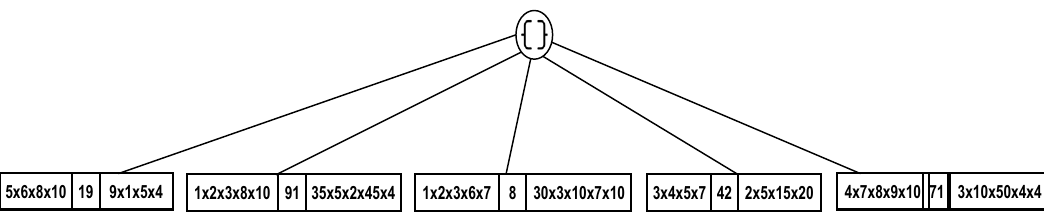
Figure 2: String Utility Tree for database 1, the items and utilities are delimited by “ x.